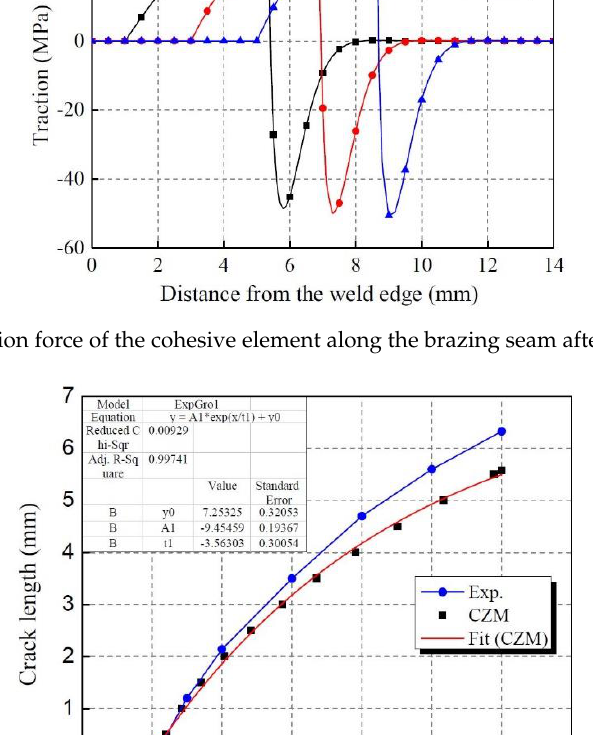
Figure 16. Traction force of the cohesive element along the brazing seam after crack growth.